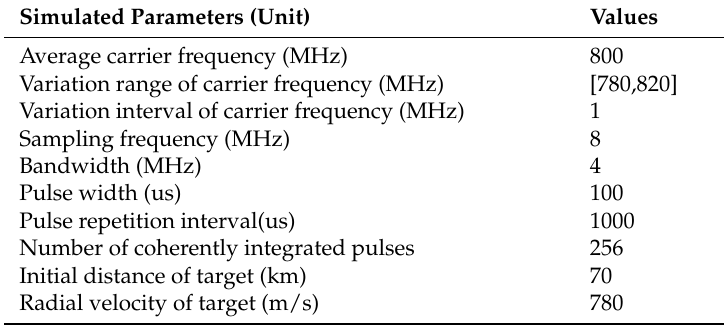
Table 1. Simulated